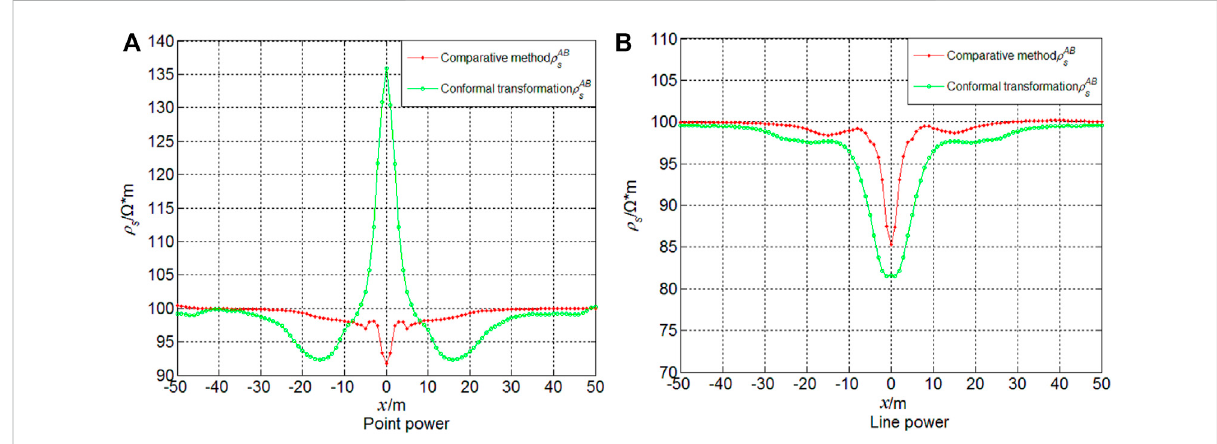
FIGURE 8 Terrain correction of the joint pro fi le anomaly curve for a valley based on the (A) point and (B) line sources.